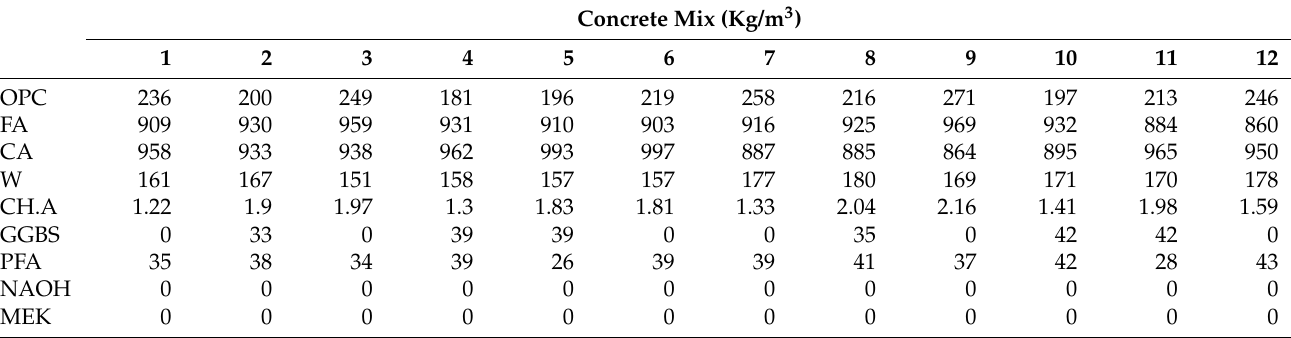
Table 12. Concrete mix optimisation extracted from Concrete Batch A